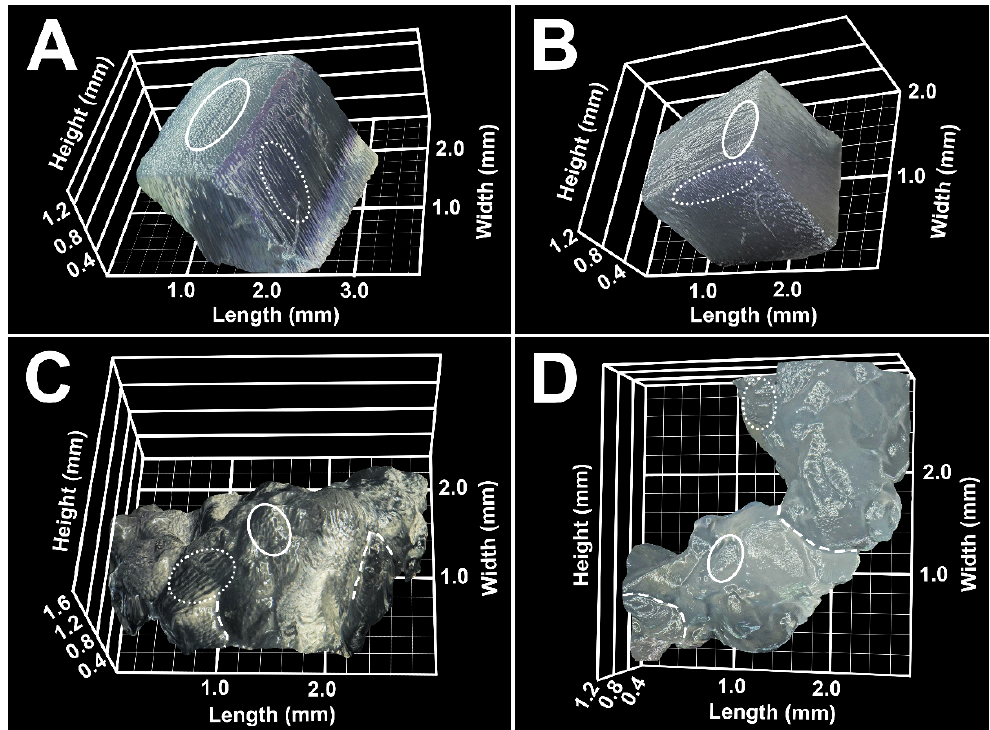
Figure 6. Microgels that comprise Capgel and Capgel-PLL needle extrusions retain the capillary microstructure present in each biomaterial prior to extrusion. Stereomicrograph 3D reconstructions of ( A ) Capgel and ( B ) Capgel-PLL cut pieces prior to extrusion. Representative areas of the capillary microstructures of each hydrogel piece are outlined with white ellipses; solid-line ellipses highlight the capillary microarchitecture viewed parallel to the capillary long-axis and dashed-line ellipses highlight capillary microarchitecture viewed perpendicular to this axis. Stereomicrograph 3D reconstructions of ( C ) Capgel and ( D ) Capgel-PLL 25 G needle extrusions; the different ellipses highlight the same orientations described above, and the white dashed lines highlight borders between entangled microgels.